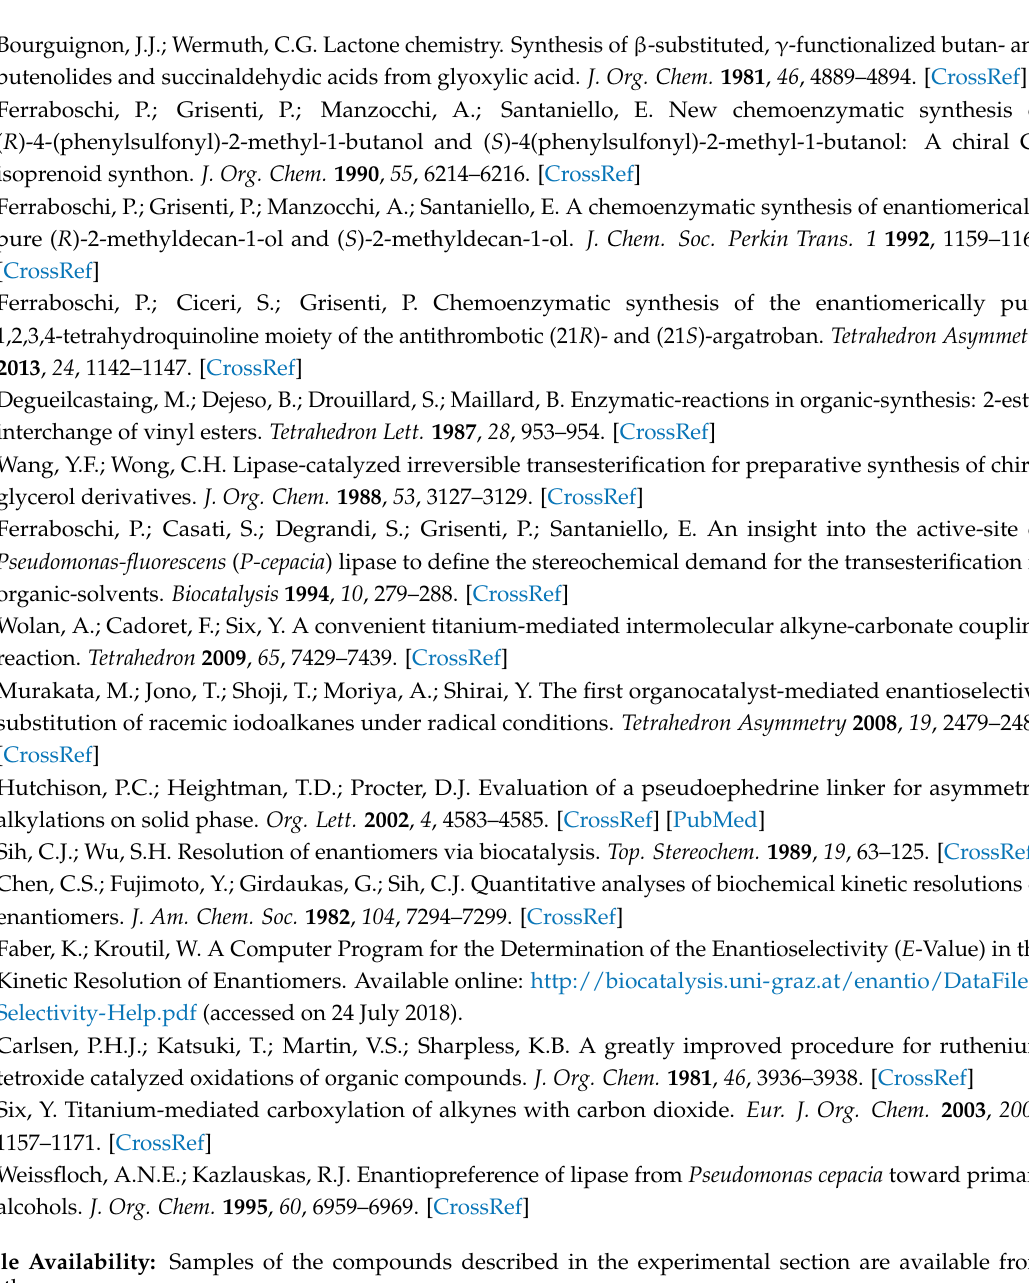
Sample Availability: Samples of the compounds described in the experimental section are available from the